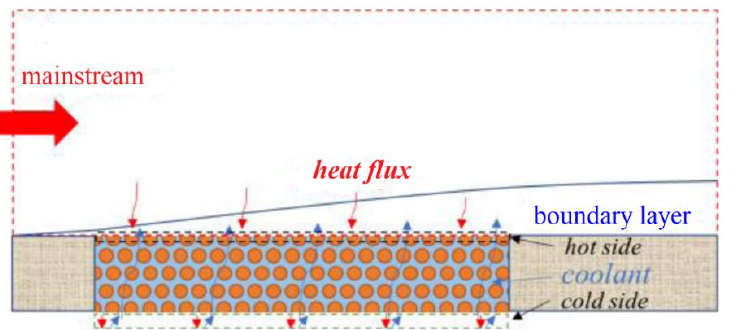
Figure 8. Mechanism description of transpiration cooling. Reprinted/adapted with permission from Ref. [113] . OPEN ACCESS.